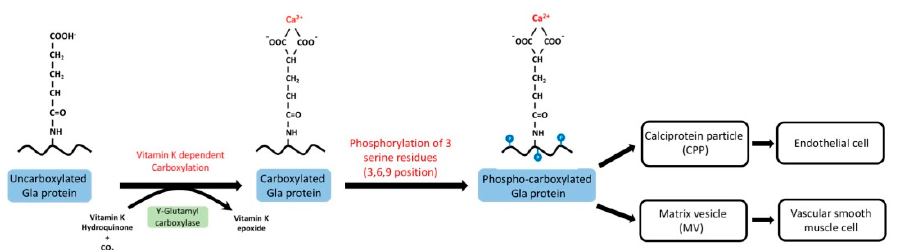
Figure 2. Phosphorylation and carboxylation process of matrix Gla protein (MGP). Vitamin K is a crucial cofactor for the post-translational γ -carboxylation of glutamic acid residues in MGP. Vascular calcification in the extracellular matrix is initiated by the deposition of minerals and MGP-containing calciprotein particles (CPPs) and matrix vesicles (MVs). Mineral nucleation within CPPs and MVs is blocked in the presence of mineral inhibitors, such as phosphorylated carboxylated MGP (p-c MGP) and fetuin-A. However, uncarboxylated MGP and fetuin-A deficiency in chronic kidney disease (CKD) result in an increased level of mineral maturation followed by the calcification of vascular smooth muscle cells.